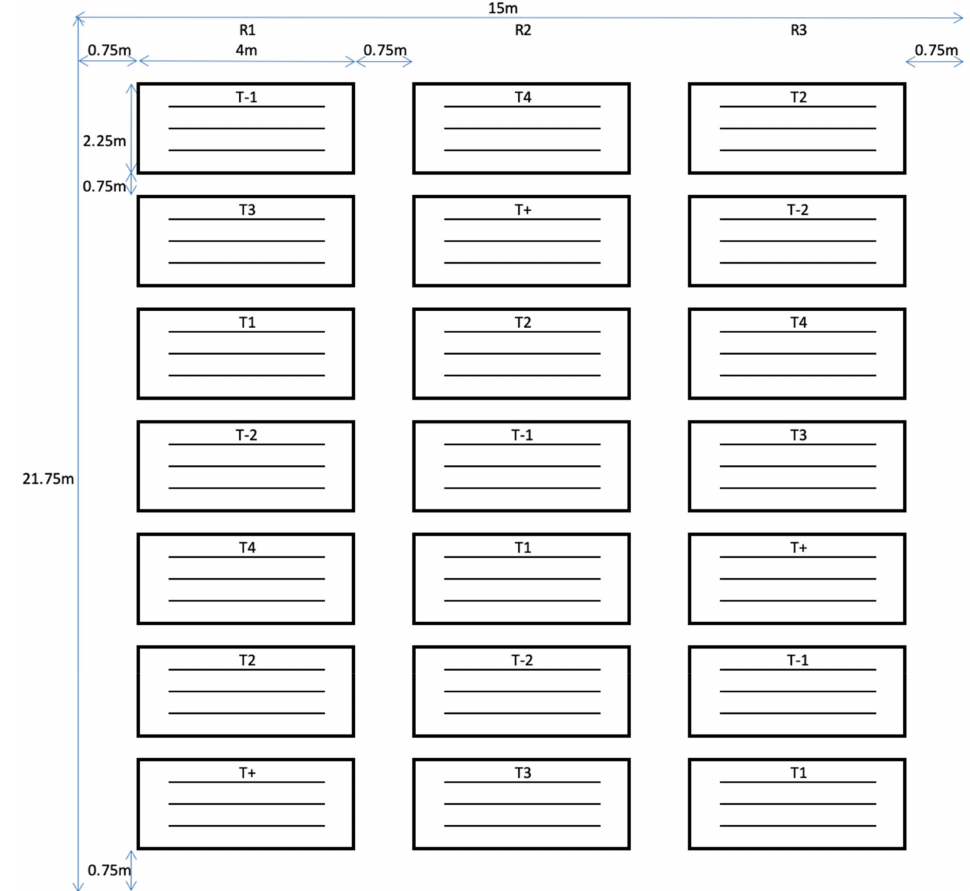
Figure 1. Experimental design of the experiment to assess the antibiosis of lines infested by larvae of Spodoptera frugiperda on leaves, on silks and ears (see Section 2.6). R1: 1st block; R2: 2nd block; R3: 3rd block; T-1: Plot of CML444; T-2: Plot of CKSBL10025; T +: Plot of Mp716; T1: Plot of CML71; T2: Plot of CML125; T3: Plot of CML370; T4: Plot of